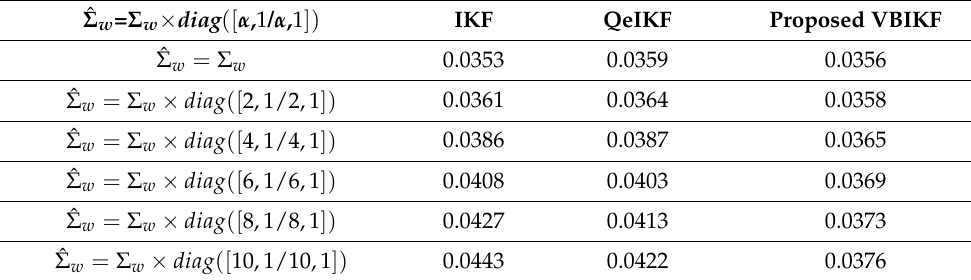
Figure 1. The ARMSE result of the IKF, the QeIKF, and the VBIKF for the scaled ˆ Table 1. The ARMSE result of the different filtering methods with ˆ Σ w of different Table 1. The ARMSE result of the different filtering methods with ˆ